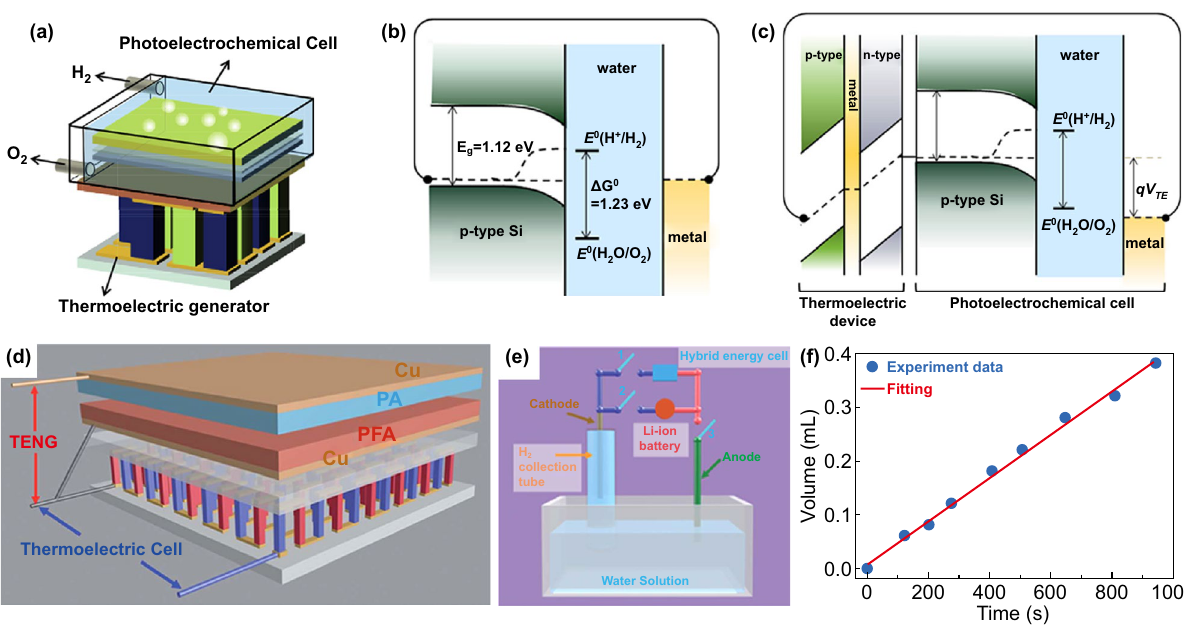
Fig. 12 a Schematic diagram of a PEC-TE hybrid device. Energy band diagrams of b sole PEC and c a PEC-TE hybrid circuit under illumina- tion depicting the influence of qV TE . Reproduced with permission from Ref. [162]. Copyright 2015 Elsevier Inc., d schematic diagram of the fabricated TENG-TE hybrid energy cell, e schematic diagram of the self-powered system for water splitting to produce H 2 , f produced volume of H 2 at different working times. Reproduced with permission from Ref. [164]. Copyright 2013 Royal Society of